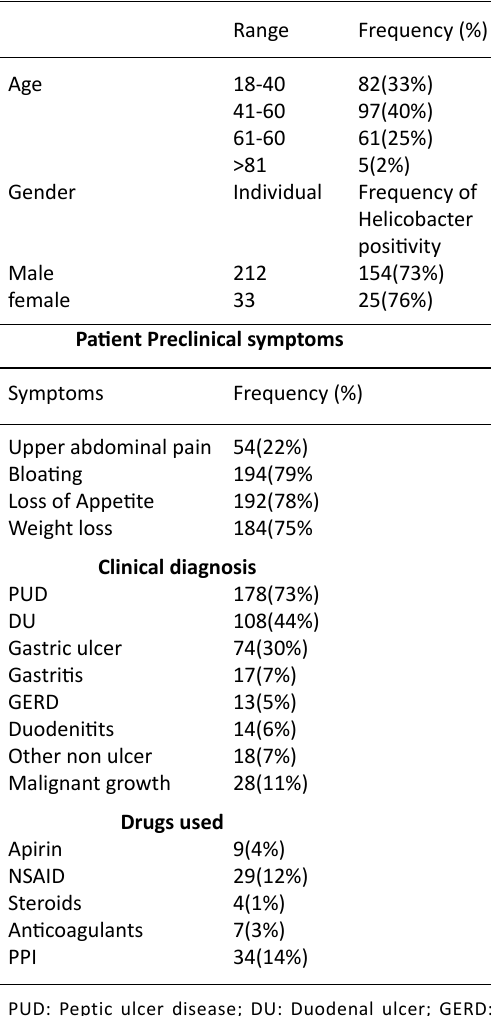
Table 3. Demographic variables of all participants